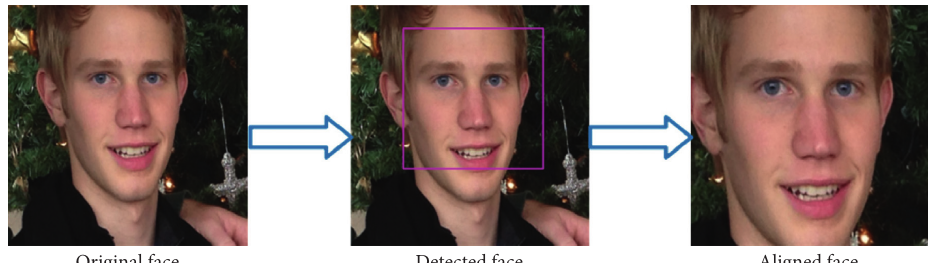
Figure 2: The image preprocessing